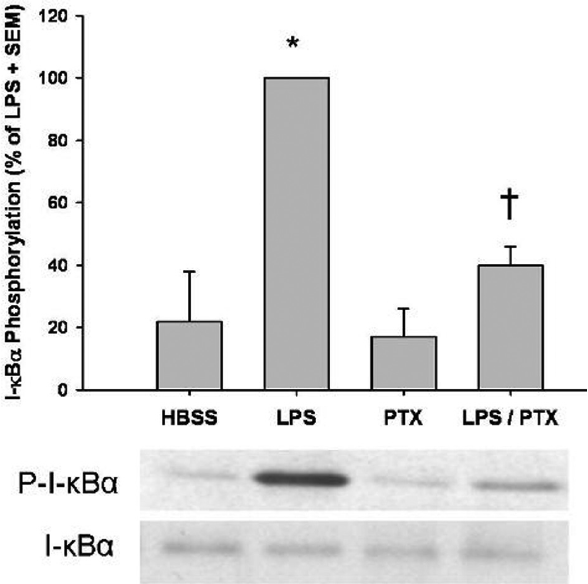
Figure 2 - Phosphodiesterase inhibition attenuates LPS-induced I- κ B α phos- phorylation. Isolated human mononuclear cells (5 x 10 6 ) were incubated with LPS (1 µg/mL) and Pentoxifylline (PTX; 20 mM). I- κ B α phosphorylation was assessed by western blotting, as described in Materials and